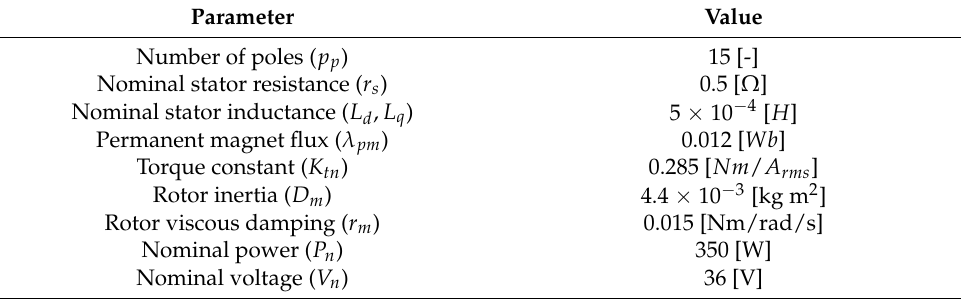
Table 2. IWSM parameters.